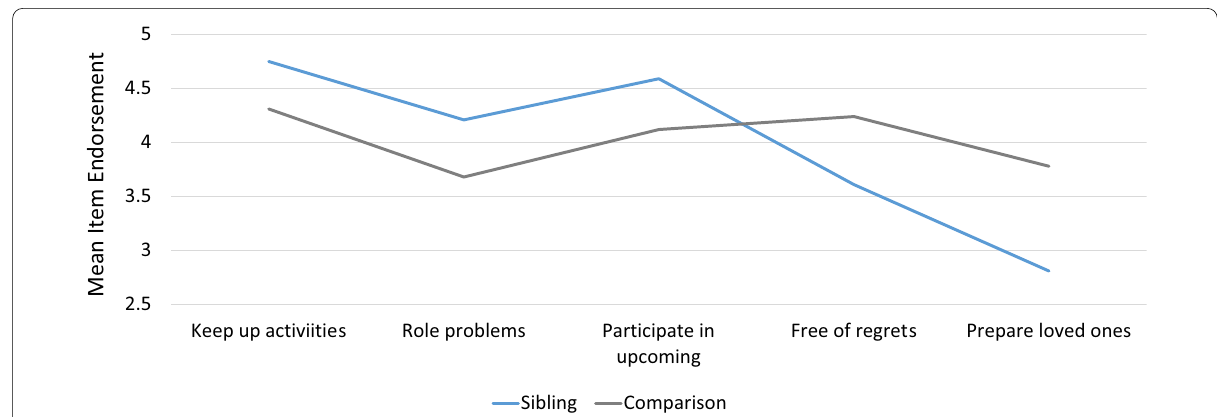
Fig. 1 Goal Item Endorsement by Role . Unadjusted means are shown for siblings (blue line) and comparison participants (grey line) on the closed-ended goal items with the most substantial